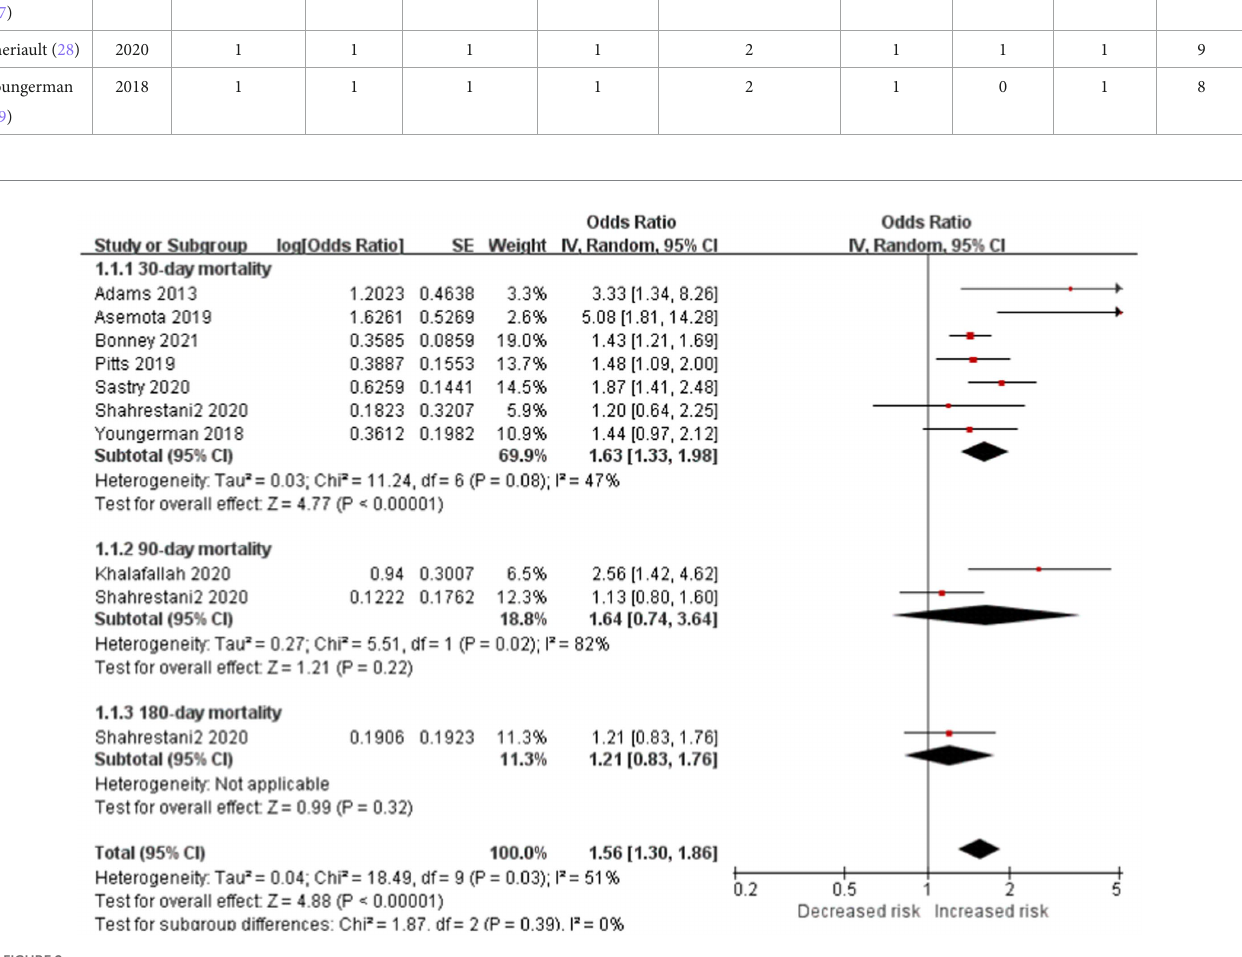
FIGURE 2 Forest plots presenting frailty is the risk of mortality in brain tumor